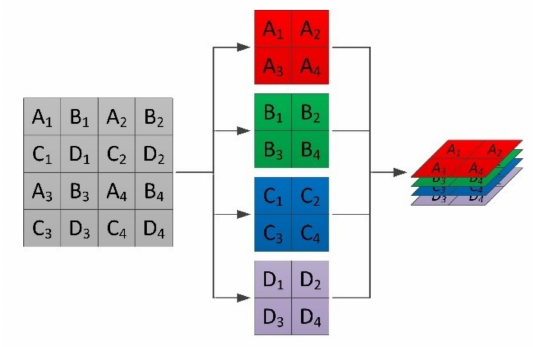
Figure 2. Schematic of